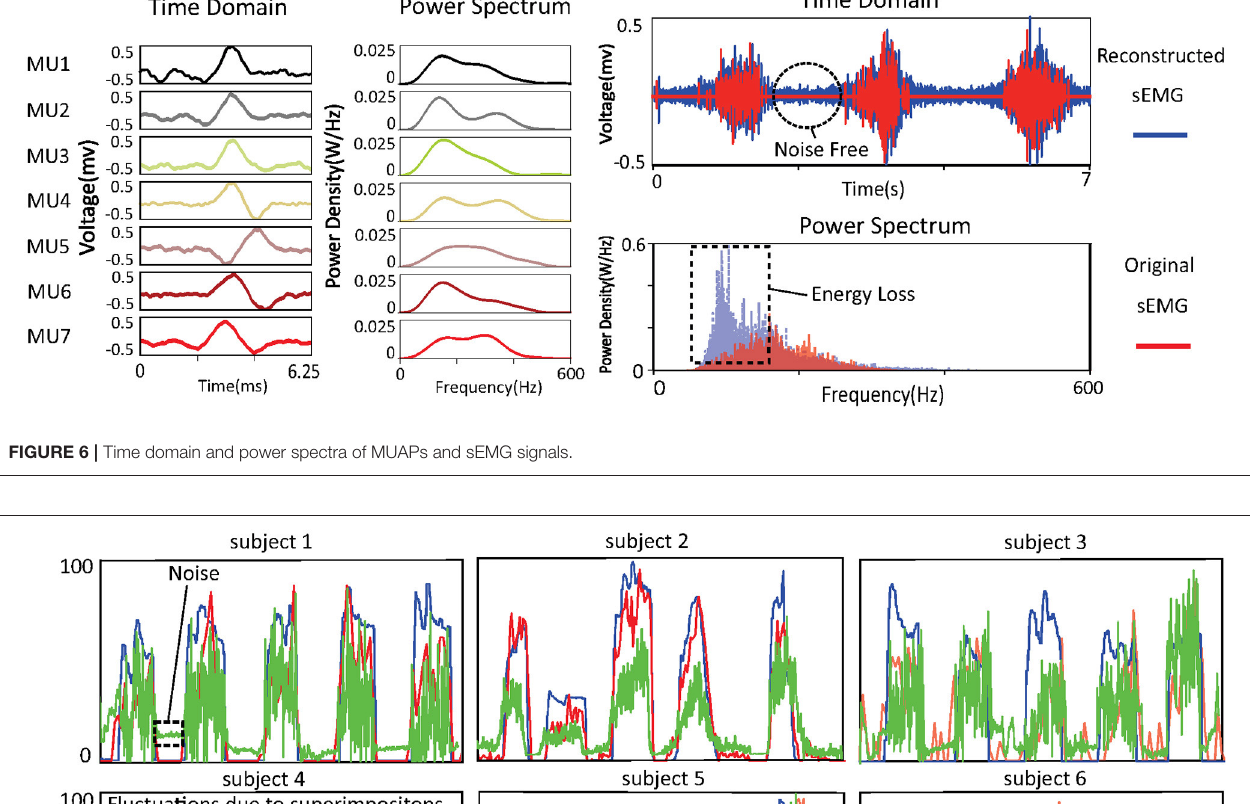
grasping included a spoon, a mobile phone, a tea tube, a coffee canister, a flash drive, a bottle, a plate, a pen, a computer mouse, and a charger. The procedures for each grasping experiment were as follows ( Figure 9D ): (1) the amputee picked up an object from the left white square and placed it in the right white square; (2) after successfully doing this, the amputee pushed the right